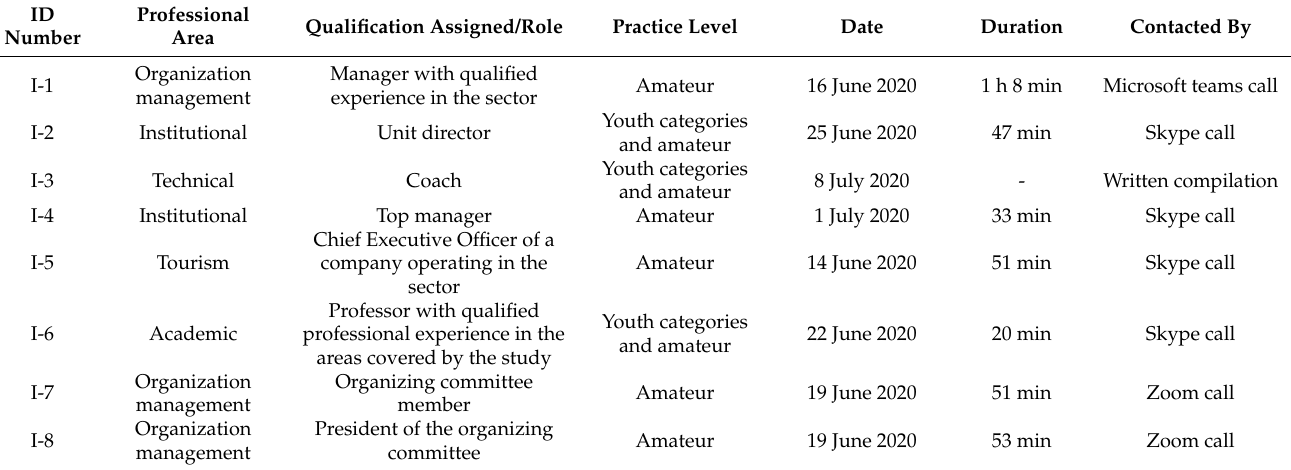
Table A2. Chart of Stakeholders